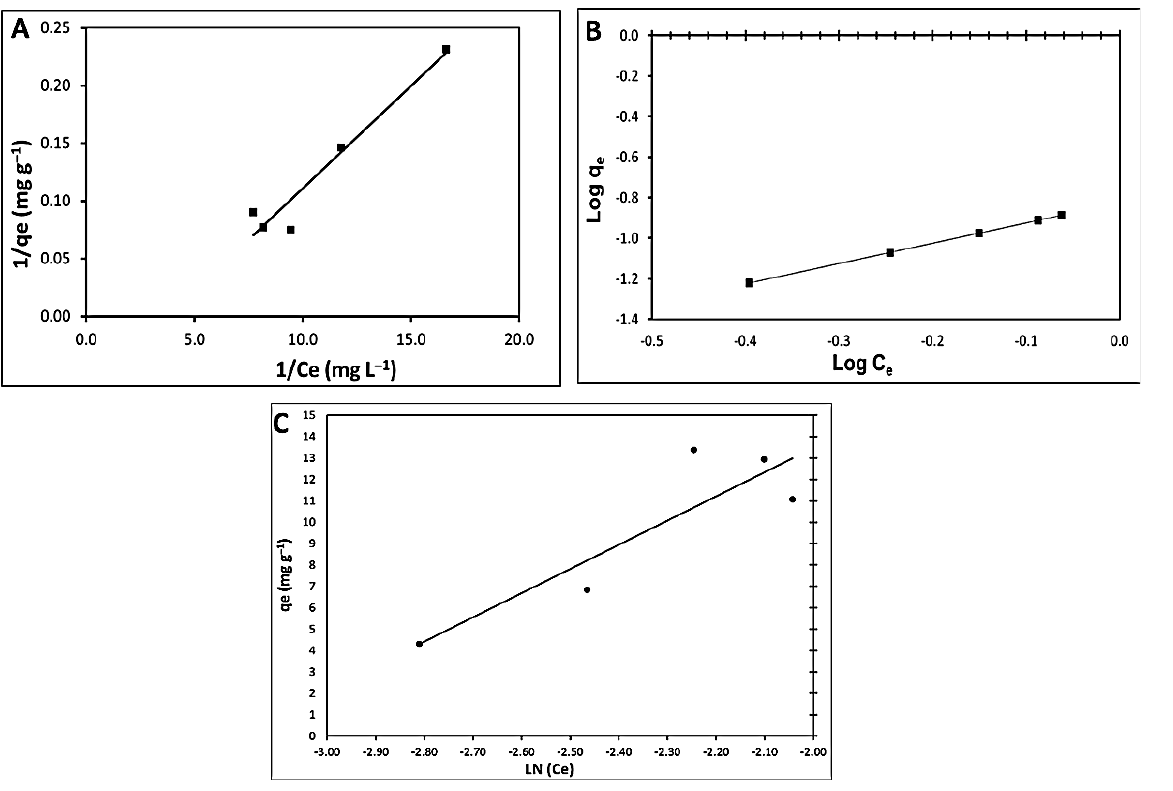
Figure 12. Linear isotherms of MBD adsorbed on A. platensis nanoparticles; ( A ) Langmuir; ( B ) Freundlich; and ( C ) Tempkin isotherm.